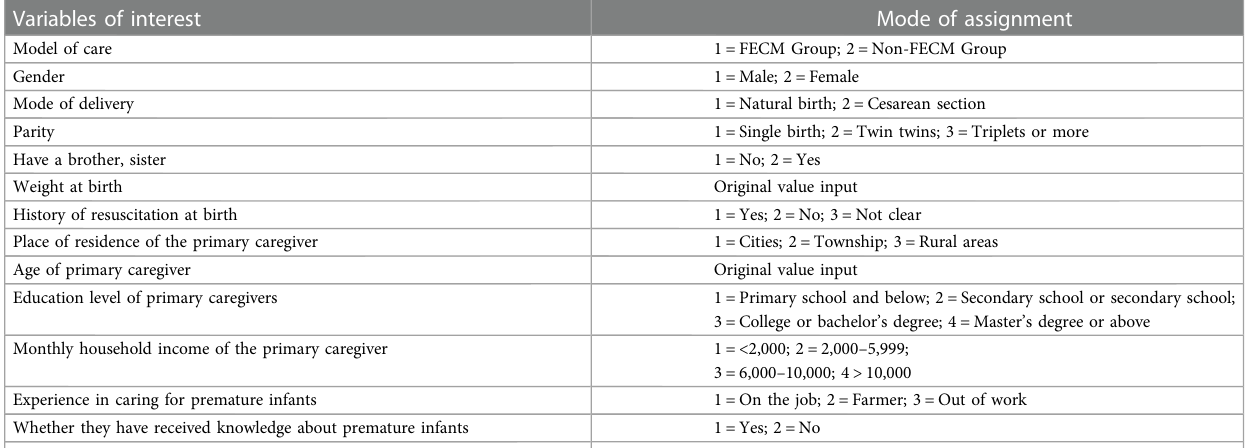
TABLE 5 Variable assignment table.